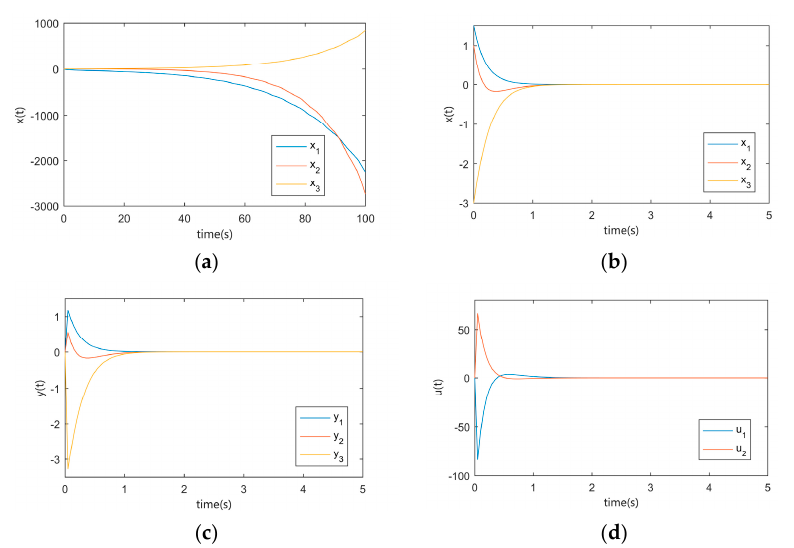
Figure 2. ( a ) State response of the open-loop system; ( b ) State response of the closed-loop system; ( c ) Output response of the closed-loop system; ( d ) Input response of the closed-loop system. Example 2